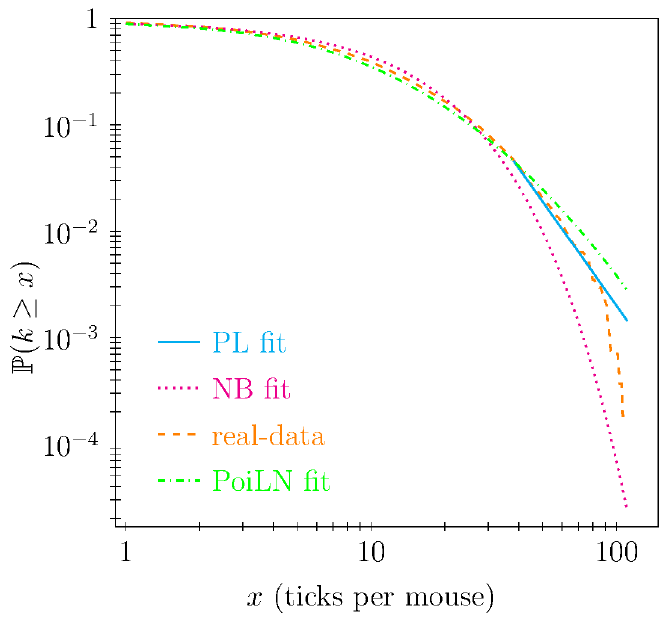
Figure 4. Complementary cumulative functions of number of ticks per host (real-data) with the best power-law (PL), negative binomial (NB), and Poisson LogNormal (PoiLN) fit. The PL fitting model shows high proximity to the tail of the real data distribution while the NB and the PoiLN fits appropriately describe the initial part of the distribution they describe the tail improperly.